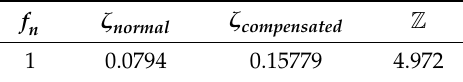
Figure 8. Drone depth dynamic behavior: in the blue line the normal (uncompensated) damping; the azure line the compensated behavior; dotted lines are the upper and lower limit. The red line (out of scale) is the bladder’s “hydrostatic chute” action. Table 1. Model